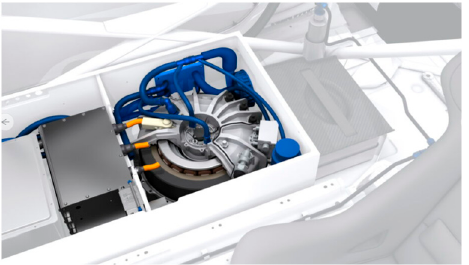
Figure 15. The front passenger seat in the GT3 R Hybrid is reserved for the flywheel.